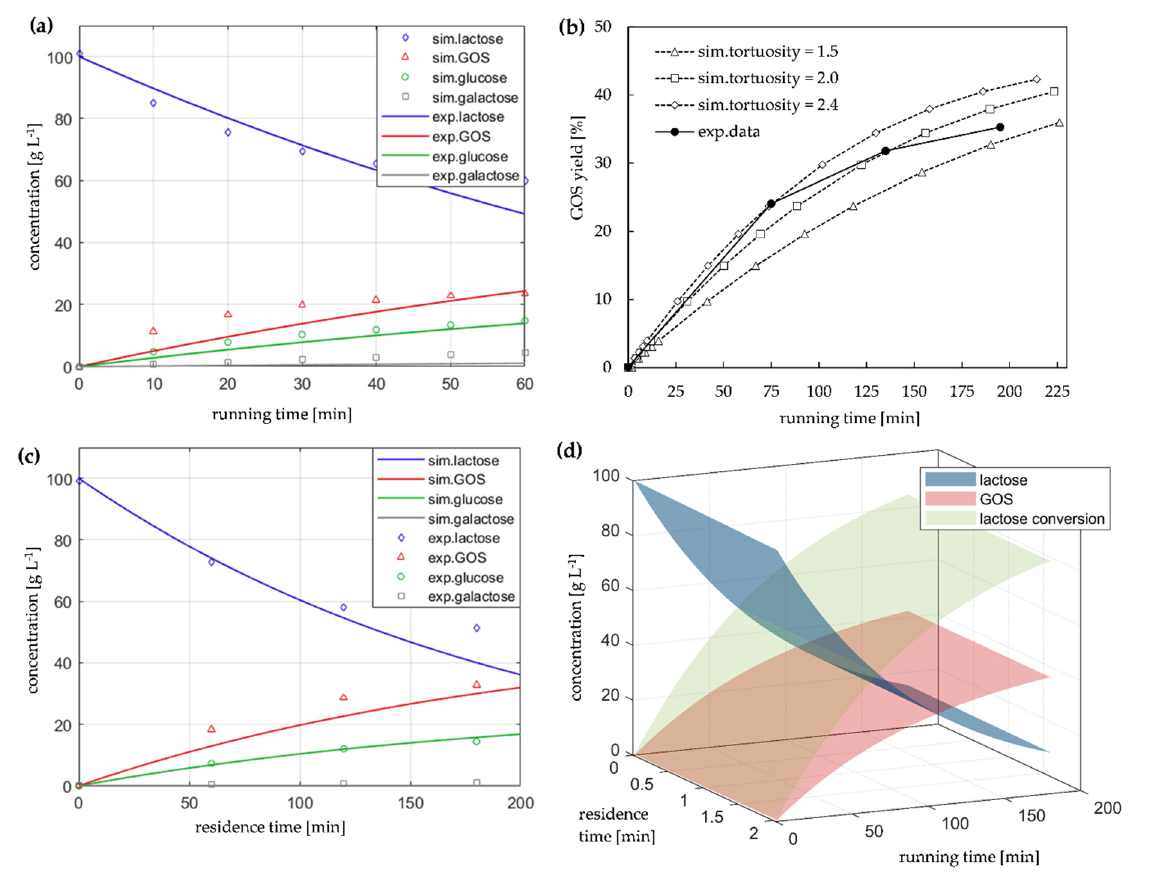
Figure 7. Modeling the GOS synthesis process with immobilized enzyme reactor: ( a ) reference system: concentration profiles of the discontinuous batch-reactor with free enzyme; ( b ) evaluation of tortuosity: GOS yield obtained with immobilized enzyme; ( c ) simulated and experimental data for immobilized enzyme; ( d ) 3D-plot of simulated data for the immobilized enzyme; ( b – d ) semi-continuous configuration with immobilized β -gal on disk-PTFR, flow = 0.1 mL min − 1. Table 4. Experimental and model-based characterization of the monolithic reactor.